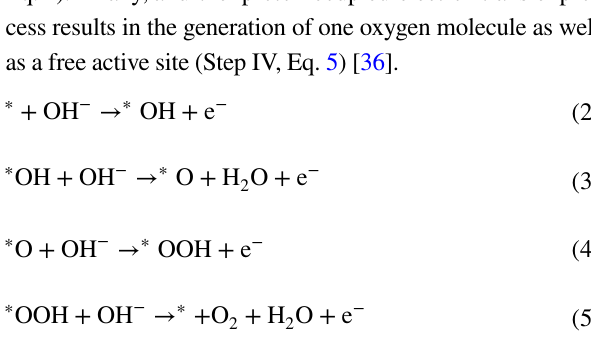
Fig. 2 The OER catalytic cycle based on AEM. Here, * represents the surface-active TM cation. The four elementary steps I, II, III, IV correspond to Eqs.